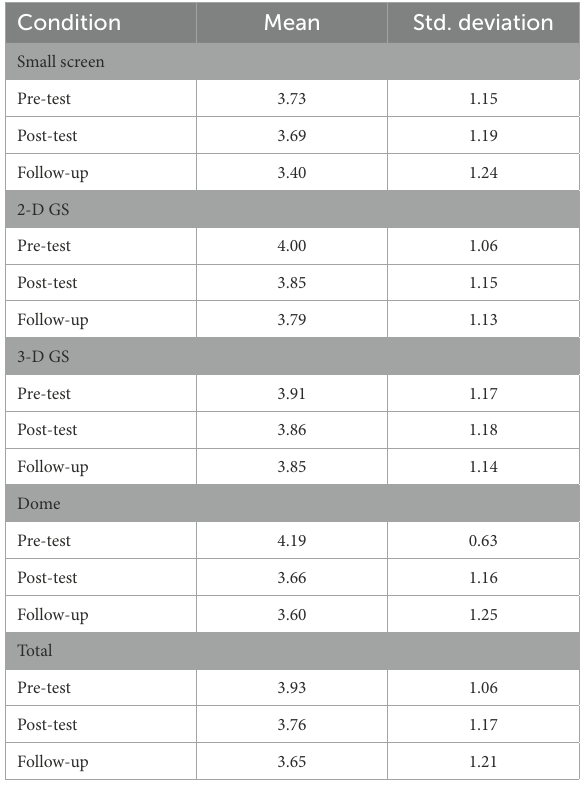
TABLE 3A All Descriptives. “I like Science” Descriptives for the four conditions at three time